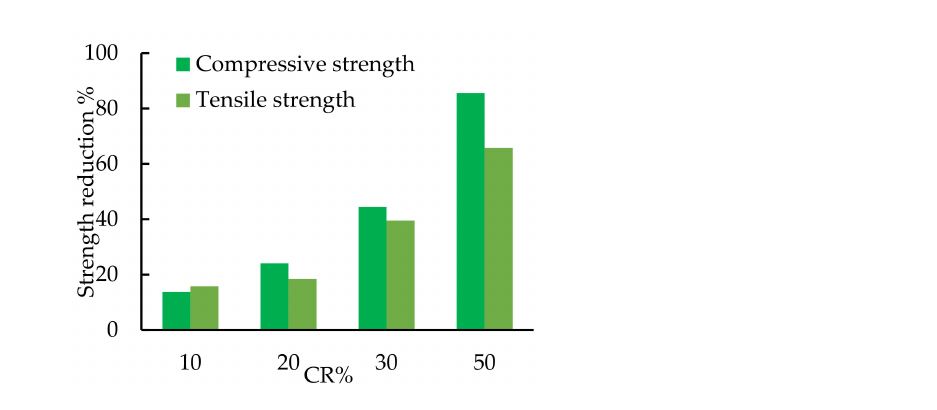
Figure 7. The percentage reduction for both compressive and tensile strengths with CR%.